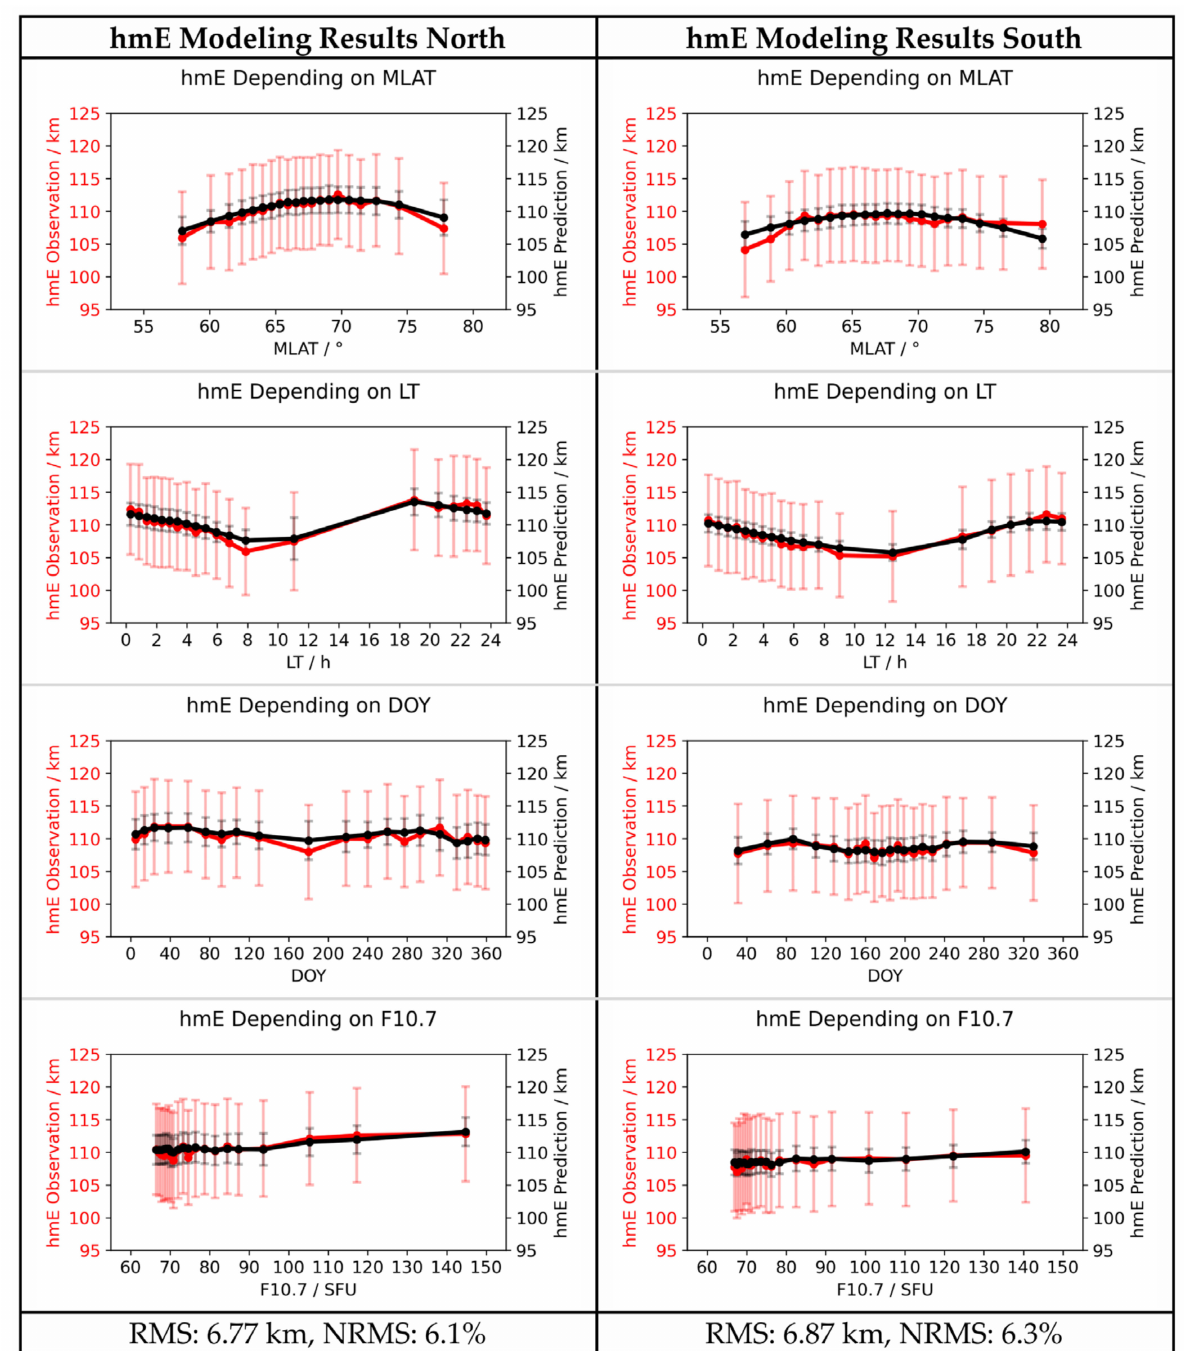
Figure 3. Observed (red) and predicted (black) hmE trends for the modeling dataset. Left column: Northern Hemisphere. Right column: Southern Hemisphere. Last row: RMS and NRMS deviation between observation and